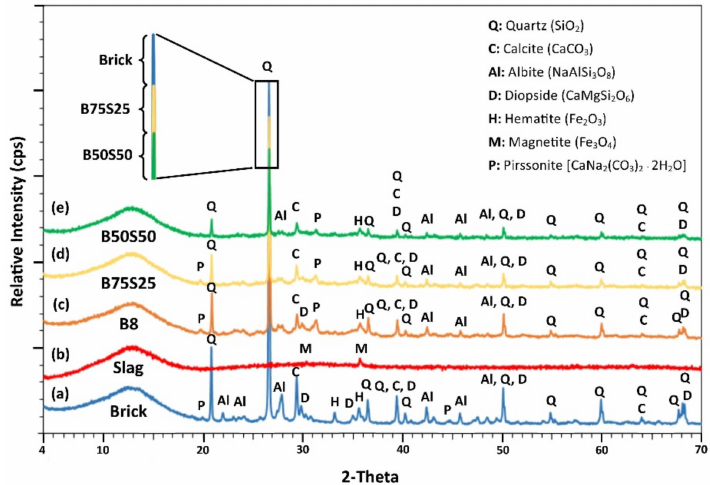
Figure 6. XRD patterns of ( a ) raw brick, ( b ) raw slag as raw materials, and of the IPs produced using ( c ) brick waste (B8), ( d ) 75 wt % brick and 25 wt %. slag (B75S25) and ( e ) 50 wt %. brick and 50 wt % slag (B50S50) under the optimum conditions; i.e., H 2 O / Na 2 O = 18.21 and curing at T = 90 ◦ C. Phases such as quartz (SiO 2 ), calcite (CaCO 3 ), albite (NaAlSi 3 O 8 ), diopside (CaMgSi 2 O 6 ), pirssonite (Na 2 Ca(CO 3 ) 2 · 2H 2 O), hematite (Fe 2 O 3 ) and magnetite (Fe 3 O 4 ) were detected in the raw